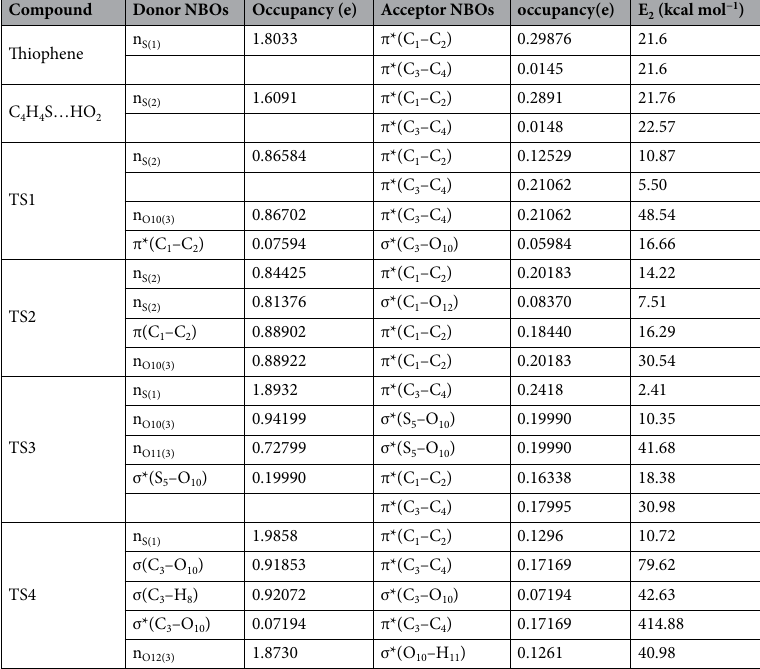
Table 3. The second-order perturbation theory analysis of the Fock matrix using NBO calculations for some species in the thiophene plus hydroperoxyl radical reaction.